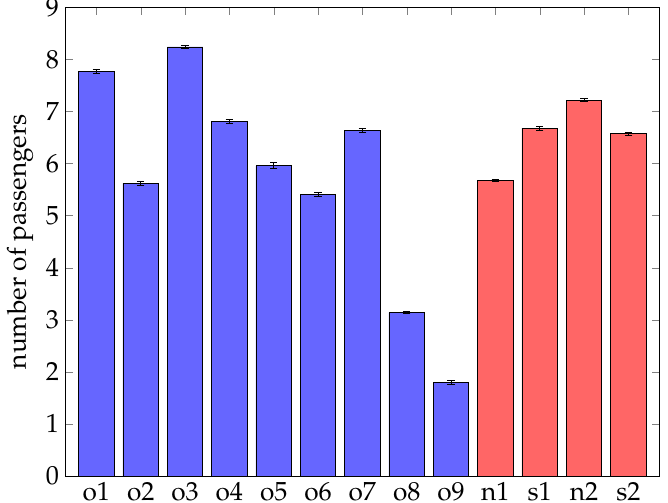
Figure 15. The mean system occupation (and their standard errors) for the thirteen security checkpoint lanes, based on the same periods as Figure